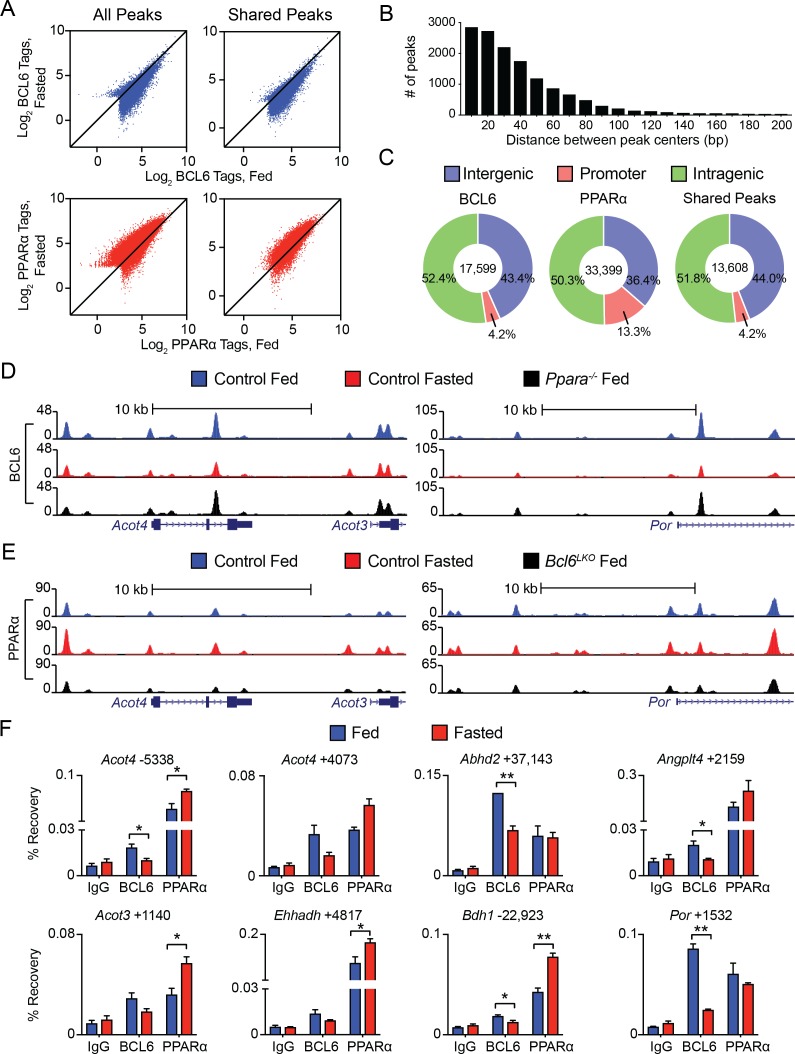
BCL6 and PPARα reciprocally bind to shared regulatory regions near fasting genes.(A) Fed and fasted BCL6 (top) and PPARα (bottom) ChIP-seq tag densities at all respective sites (left panel) or at shared sites (right panel). (B) Histogram of distances between BCL6 and PPARα peak centers; distances < 200 bp are shown. Bin width is 10 bp. (C) Genome-wide distributions of BCL6, PPARα, and shared BCL6-PPARα ChIP-seq peaks at intergenic, promoter, and intragenic regions. (D,E) UCSC genome browser tracks for ChIP-seq of BCL6 (D) or PPARα (E) in control fed (blue), control fasted (red), and genetic knockout samples as indicated in legend (black). (F) ChIP-qPCR using pre-immune IgG, BCL6, and PPARα antibodies at shared BCL6-PPARα binding sites in fed and fasted livers. Enriched regions are located at the indicated distance (in base pairs) away from the TSS of specified genes. ChIPs were performed in technical duplicates and biological triplicates. A two-tailed Student’s t-test assuming equal variance was used to compare mean values between two groups. Data are represented as mean ±SEM. ∗p<0.05, ∗∗p<0.01, ∗∗∗p<0.001.